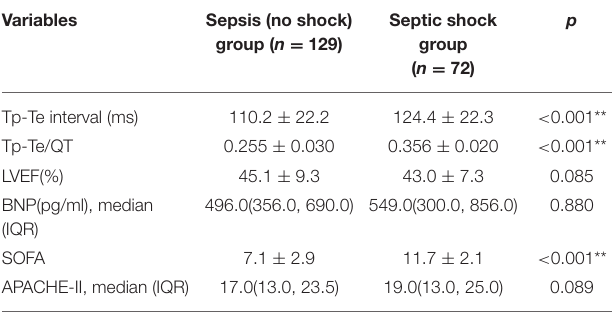
TABLE 3 | Comparison between the sepsis (no shock) group and the septic shock group.